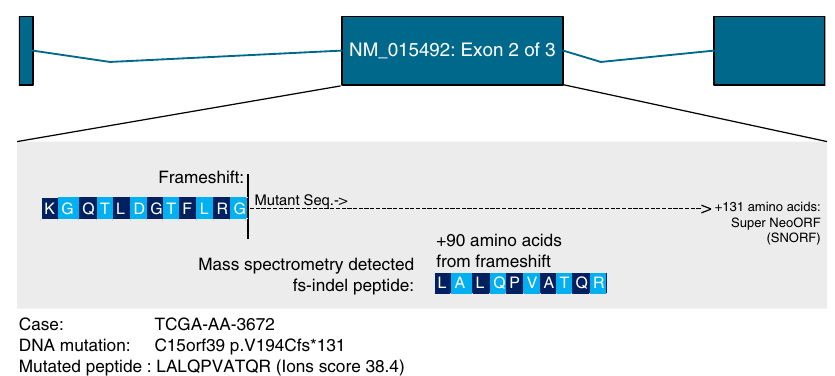
Fig. 5 Fs-indel mutated alleles detected using mass spectrometry. Shows mass spectrometry results, for spectral searches against mutant peptide sequences deriving from fs-indels. A single peptide-spectrum match (PSM) was identi fi ed from this analysis and is shown as a descriptive example. The exon structure of the fs-indel mutated gene is depicted, along with the position of the frameshift mutation, the matching peptide sequence before the frameshift, and the mutant peptide detected from the the neo open reading frame (neoORF)